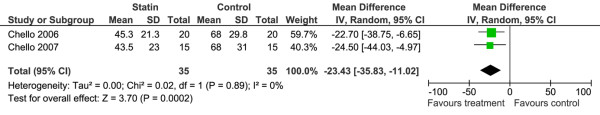
Forest plot of comparison for prophylactic statin therapy versus standard care/placebo: Inflammatory markers, outcome: IL-8.  Total refers to no. of patients per trial. CI = confidence interval; SD = standard deviation.